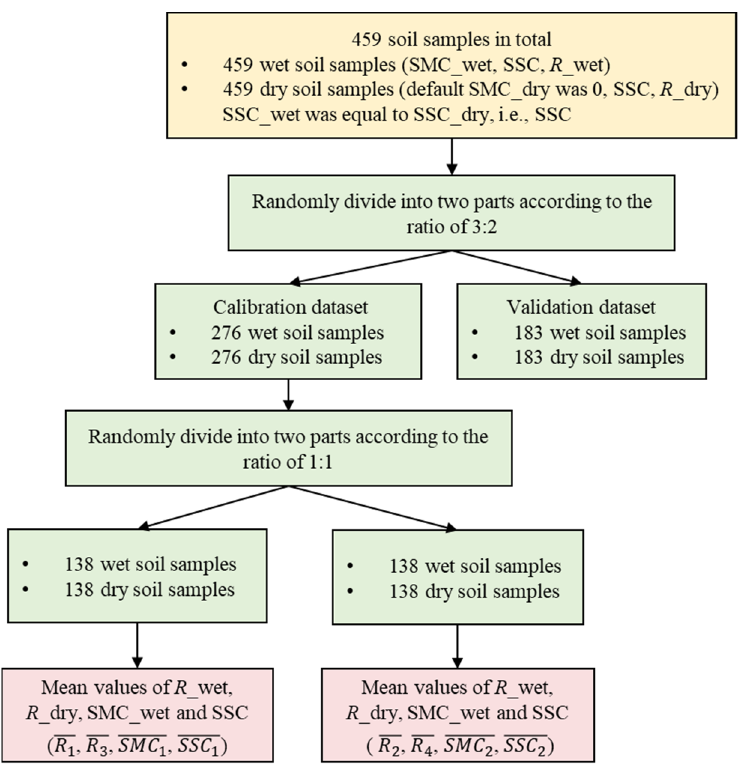
Figure 3. The workflow of splitting the validation and calibration datasets.